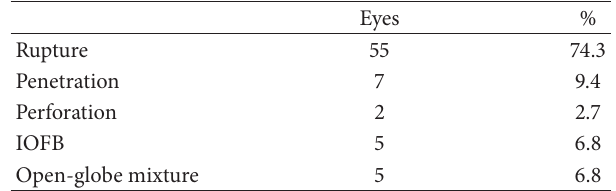
Table 1: Types of eye injury.